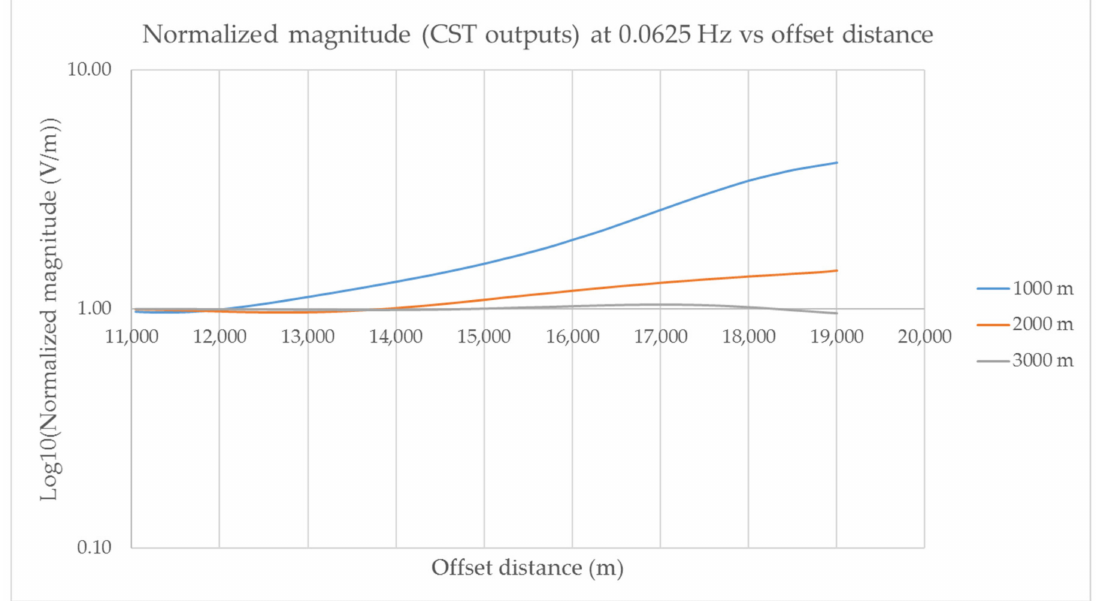
Figure 12. Normalized MVO responses for a transmission frequency of 0.0625 Hz observed along the receiver line for three di ff erent hydrocarbon depths: (i) normalized MVO for a hydrocarbon depth of 1000 m (blue); (ii) normalized MVO for a hydrocarbon depth of 2000 m (reddish-yellow); (iii) normalized MVO for a hydrocarbon depth of 3000 m